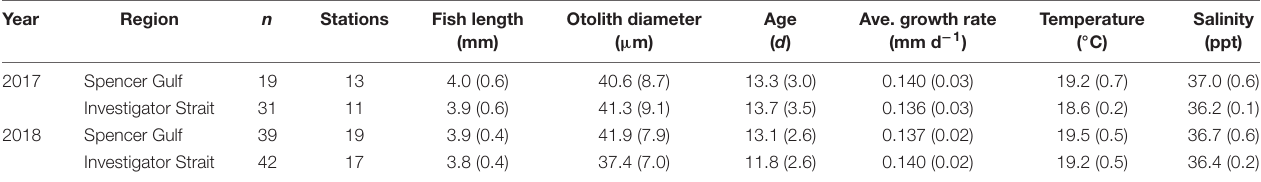
TABLE 1 | Summary of sample details used to compare otolith microstructure and elemental chemistry of larval King George whiting from Southern Spencer Gulf and Investigator Strait in 2017 and